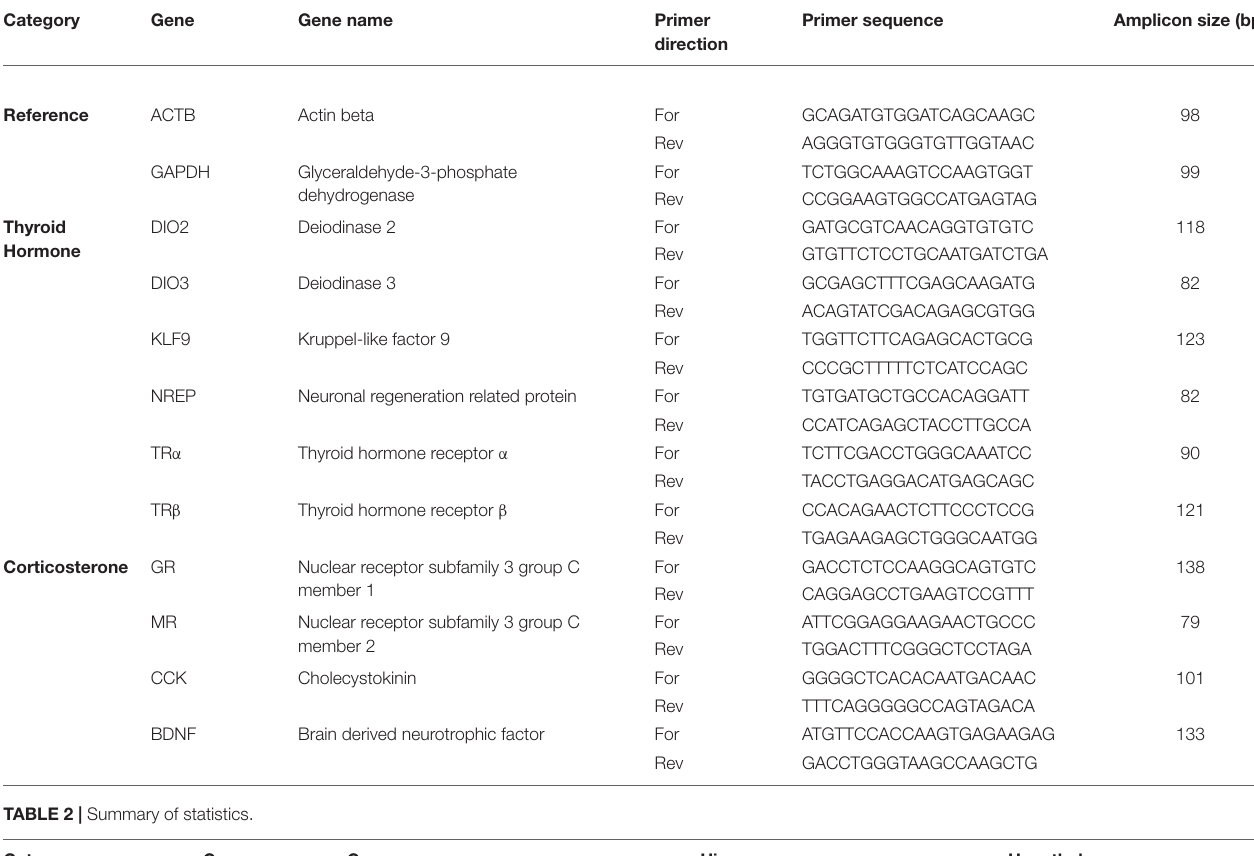
TABLE 1 | Table of primers used for quantitative PCR.